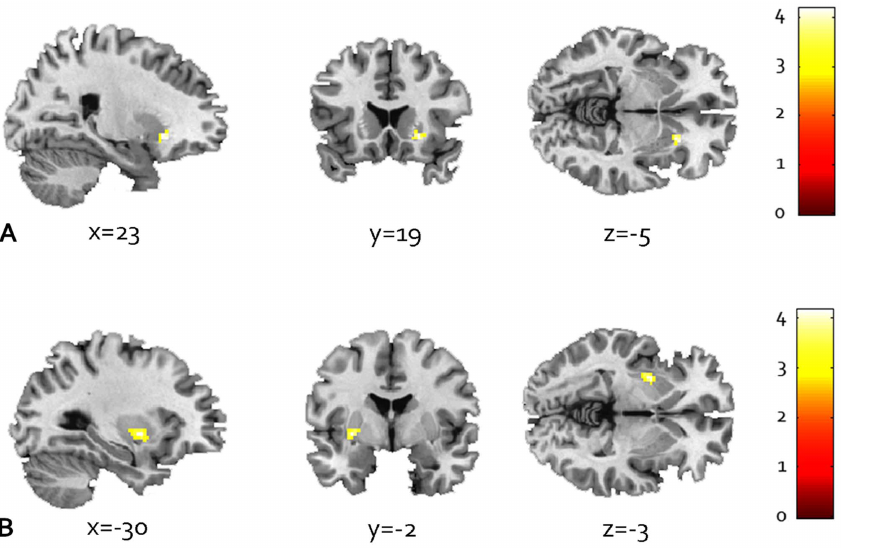
Figure 3. Regression analyses within AD group. a. A negative association between alcohol use disorder severity (AUDIT score) and cue- reactivity in the anterior putamen ( Z =3.79; P FWE , .05). b. A positive association between alcohol cue-reactivity and duration of alcohol dependence shows activation in the posterior putamen ( Z =3.64; P FWE , .05). Displayed at P , 0.005 uncorrected; cluster size threshold . =15 voxels, masked with bilateral